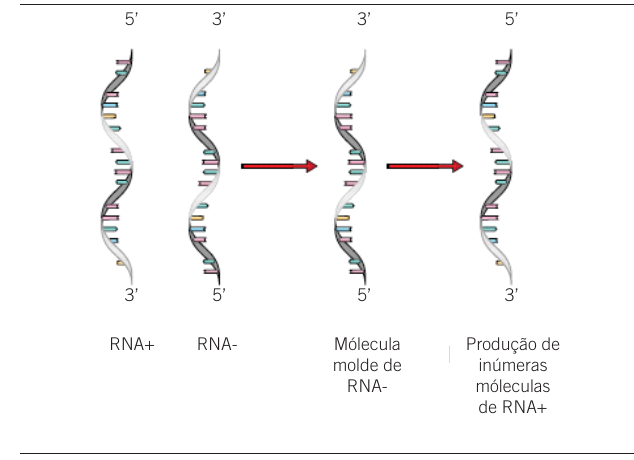
RNA+ RNA- Mólecula FIGURA 6 – Esquema da replicação viral RNA+: ácido ribonucleico positivo; RNA-: ácido ribonucleico negativo.